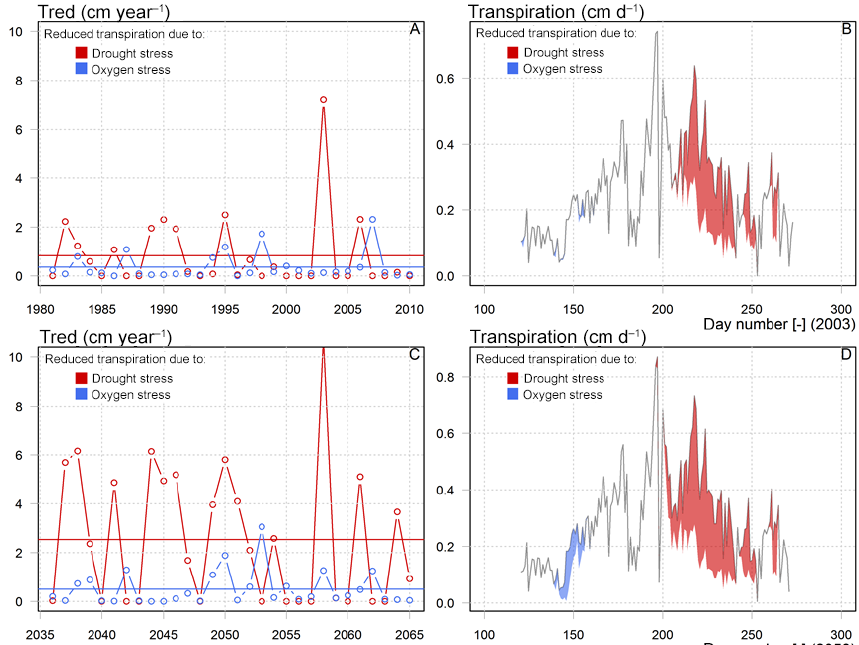
Figure 7. SWAP-WOFOST simulations of transpiration reduction due to drought stress (Treddry) and oxygen stress (Tredwet) for a silage maize crop on a fictitious sandy soil. The panels show both the different causes of stress and the different time scales the model can be used for. (a) Yearly cumulative transpiration reduction due to drought stress and the climate-average (30-year) drought stress (horizontal line). (b) Potential and actual transpiration for 2003. The red polygon, representing the difference between potential and actual transpiration, demonstrates the period and level of drought stress. (c, d, a, b) But for oxygen stress instead of drought